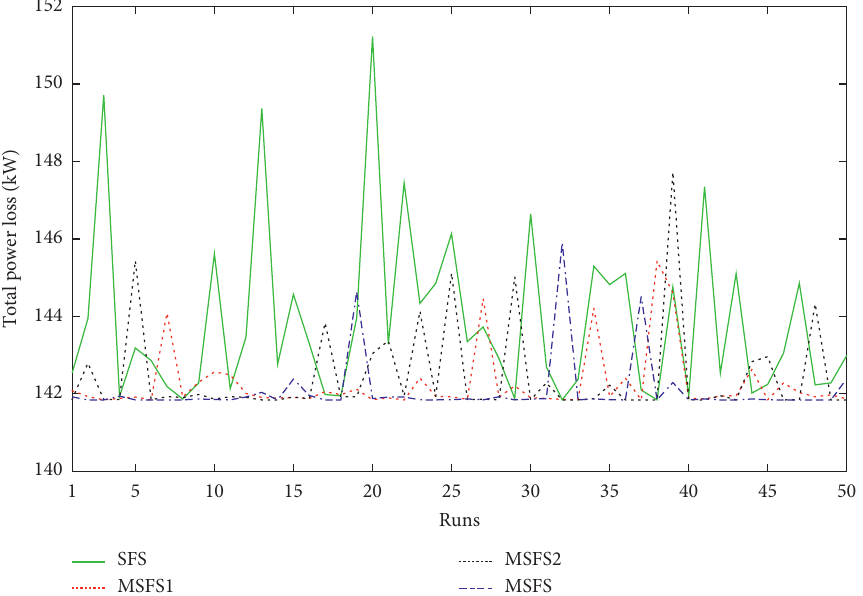
Figure 5: Total power loss of 50 trial runs obtained by SFS methods for case 1 of the 33-bus Table 2: Comparison with other methods for case 1 of the 33-bus system.